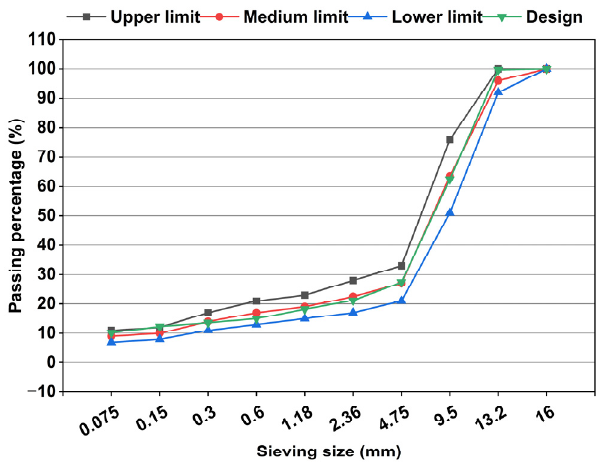
Figure 3. Grading curves of SMA ‐ 13 asphalt mixture.